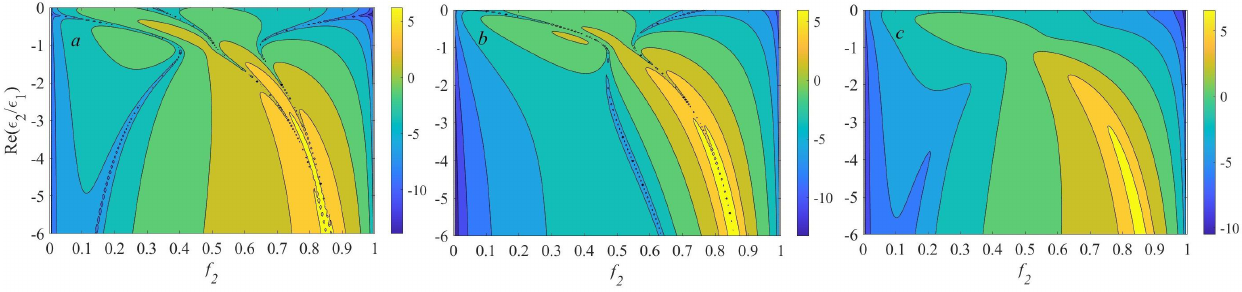
Figure 2. The isolines of ( a ) |(cid:60) ( B 2 ) | , ( b ) |(cid:61) ( B 2 ) | , and ( c ) | B 2 | , shown as a filled contour plot on the f 2 - (cid:60) ( (cid:101) 2 / (cid:101) 1 ) plane, calculated in accordance with Equation (10) (logarithmic